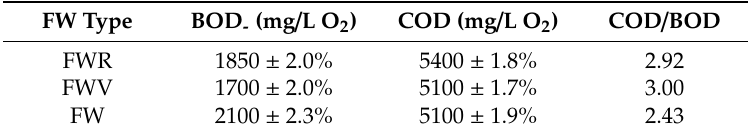
Table 3. BOD - and COD of the two FW investigated substrates, FWR, FWV and FW mixture.